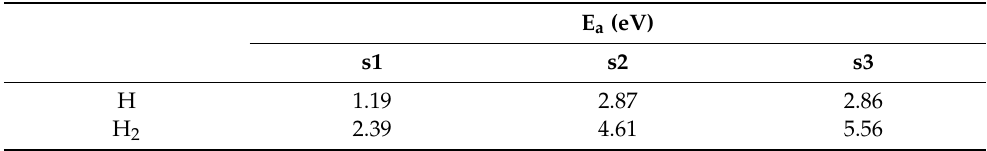
Table 1. The adsorption energies of an infinitely long hydrocarbon chain with one H and H 2 adsorbed at s1, s2, and s3 sites in the supercell, respectively.